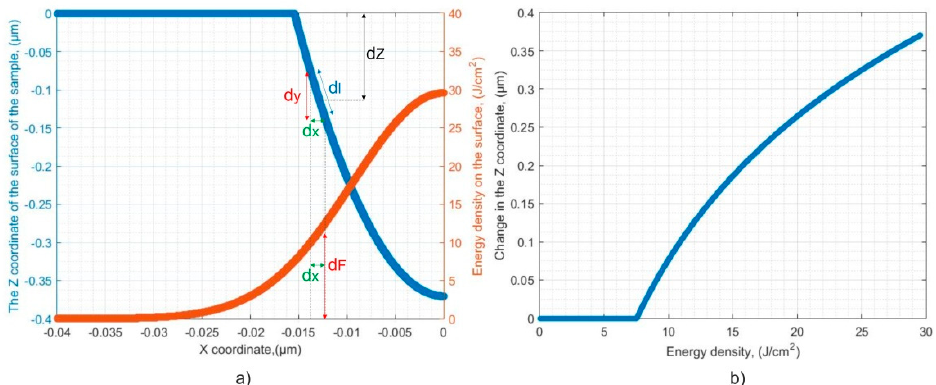
Figure 2. Change in the shape of the surface after a pulse impinges on the sample. ( a ), Coordinates of the surface (blue curve) after a Gaussian pulse (red curve) hits the surface of the sample. ( b ), derived depth vs. energy density (fluence) plot.